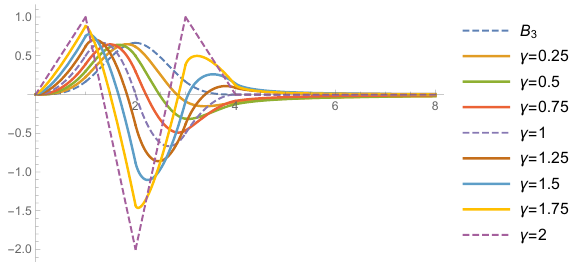
Figure 2. The fractional derivative D γ x B 3 of the cubic B-spline for different values of the fractional order γ . The cubic B-spline B 3 , its first ( γ = 1) and second ( γ = 2) derivatives are plotted as dashed